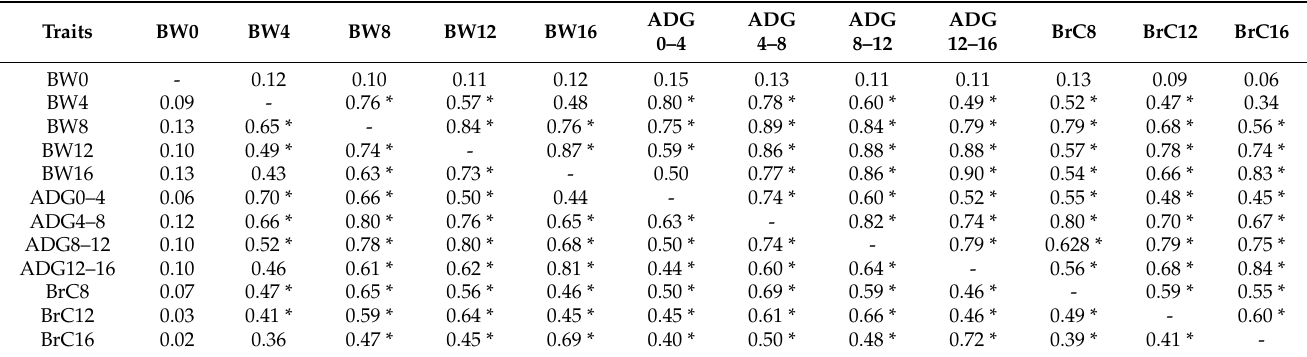
Table 2. Phenotypic correlations of growth traits between on-site farm (above diagonal) and on-station (below diagonal) Thai native chickens (Pradu Hang dum).